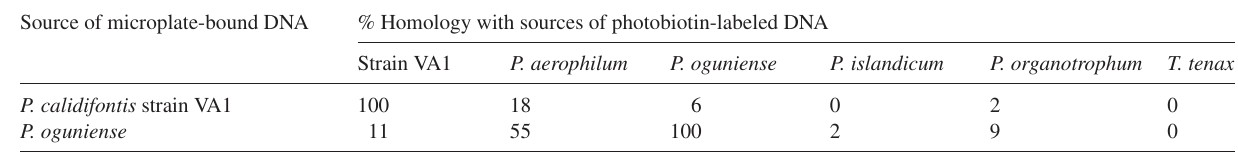
Table 1. DNA–DNA hybridization between Pyrobaculum calidifontis strain VA1, other species of the genus Pyrobaculum , and Thermoproteus tenax . Source of microplate-bound